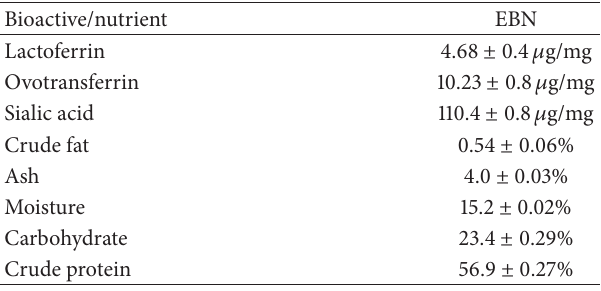
Table 3: Proximate analyses and lactoferrin, ovotransferrin, and sialic acid concentrations of edible bird’s nest (EBN).